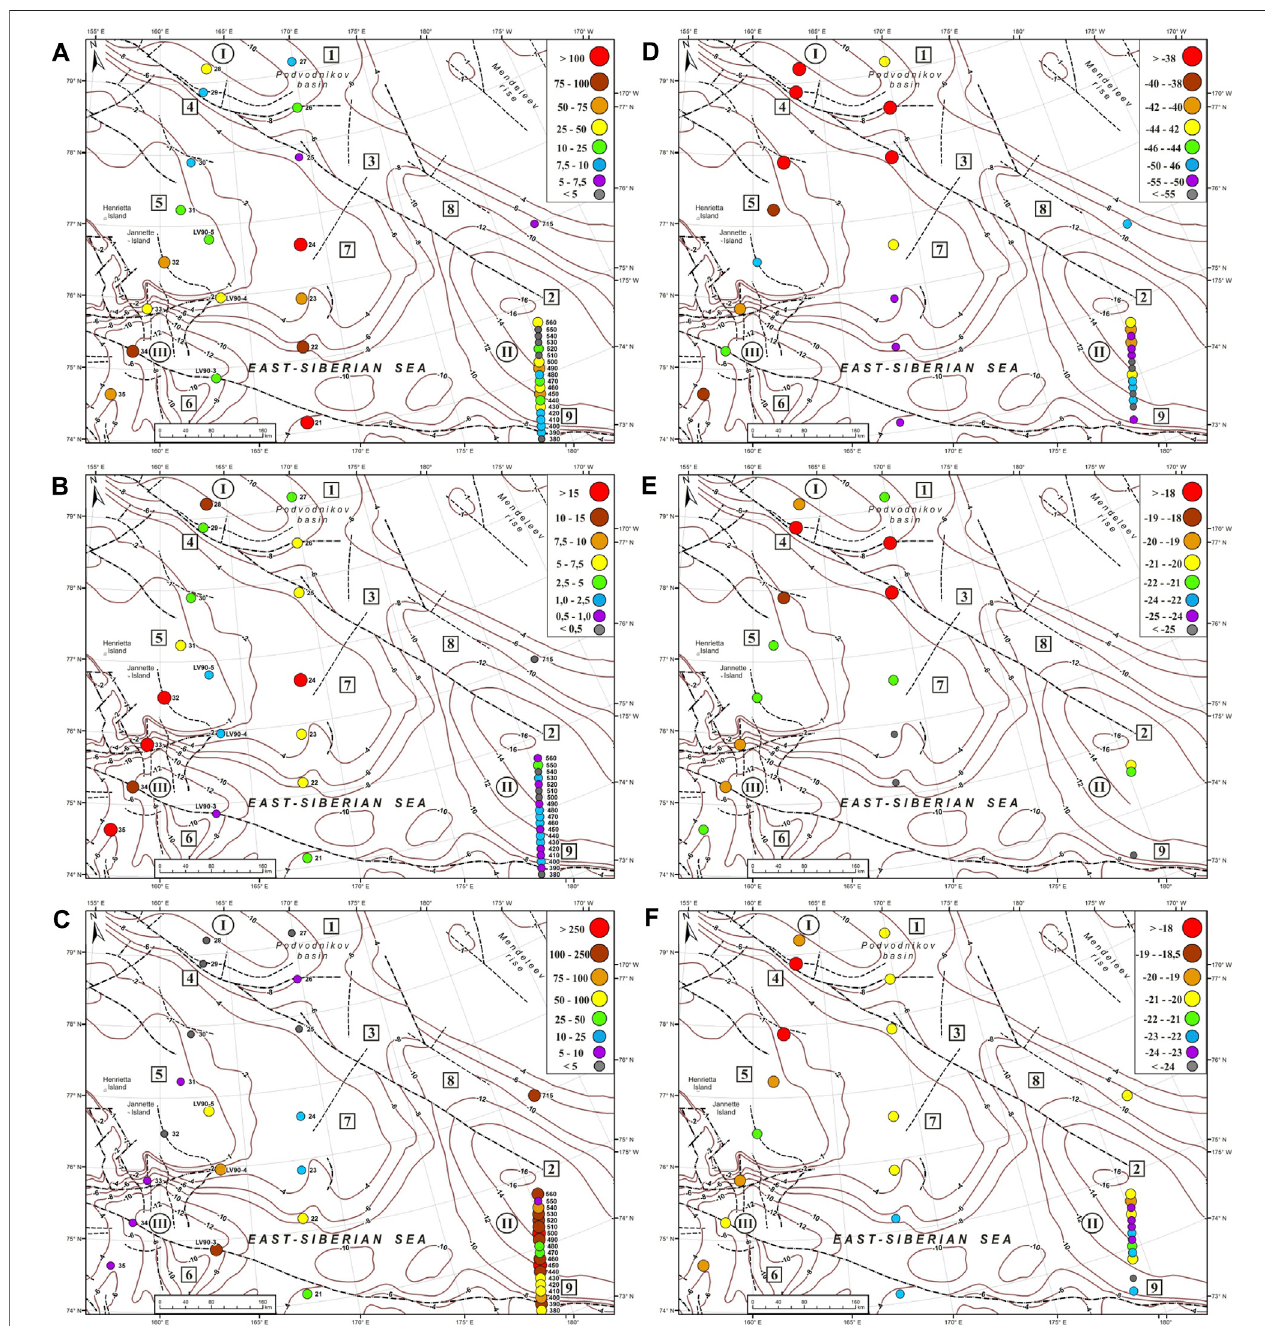
FIGURE3 | Distribution plot ofthe concentration ofCH 4 in ppm (A) , C 2 – C 5 in ppm (B) , gasratioC 1 /C 2+ (C) , and carbon isotope data of δ 13 C-CH 4 (D) , δ 13 C-C 2 H 6 (E) , and δ 13